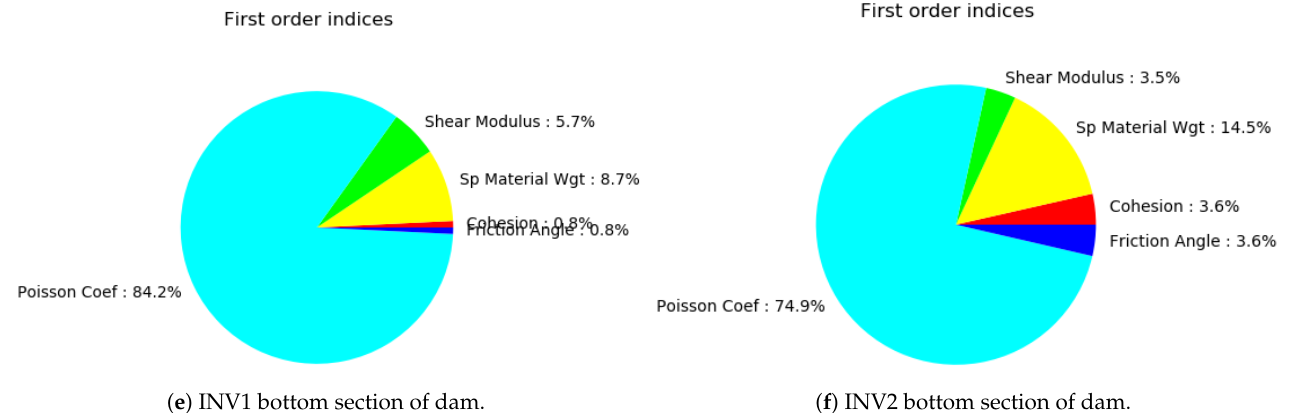
( e ) INV1 bottom section of dam. ( f ) INV2 bottom section of dam. Figure 14. The pie charts show the sensitivity indices based on DNN for INV1 and INV2 displacements, respectively.